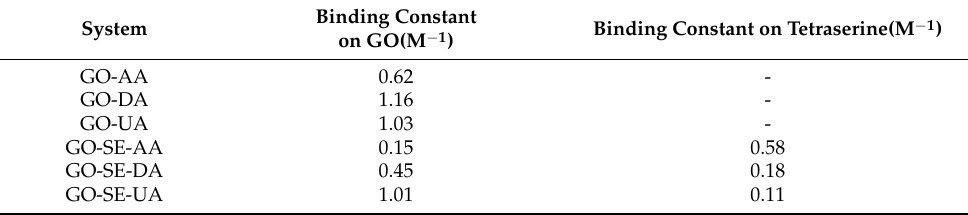
Table 1. Binding constant for GO-AA, GO-DA, GO-UA, GO-SE-AA, GO-SE-DA, and GO-SE-UA system.